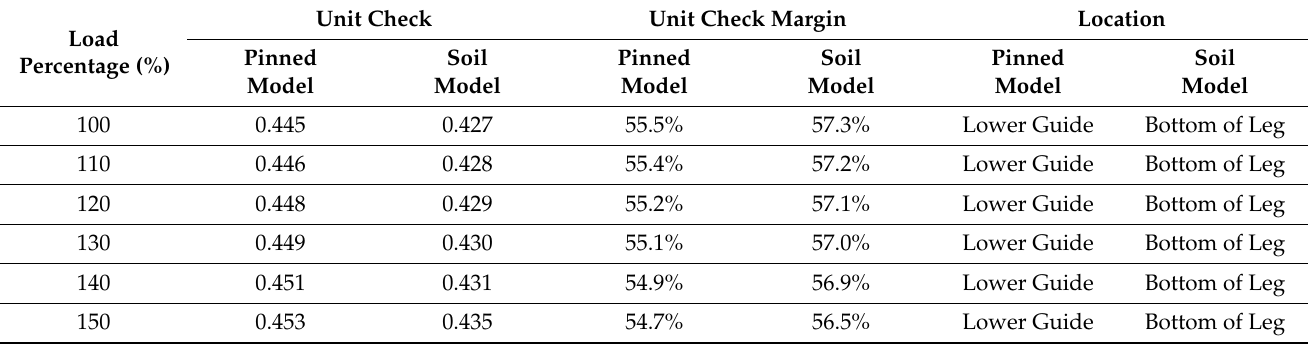
Table 8. Effect of structural response according to parameters for air